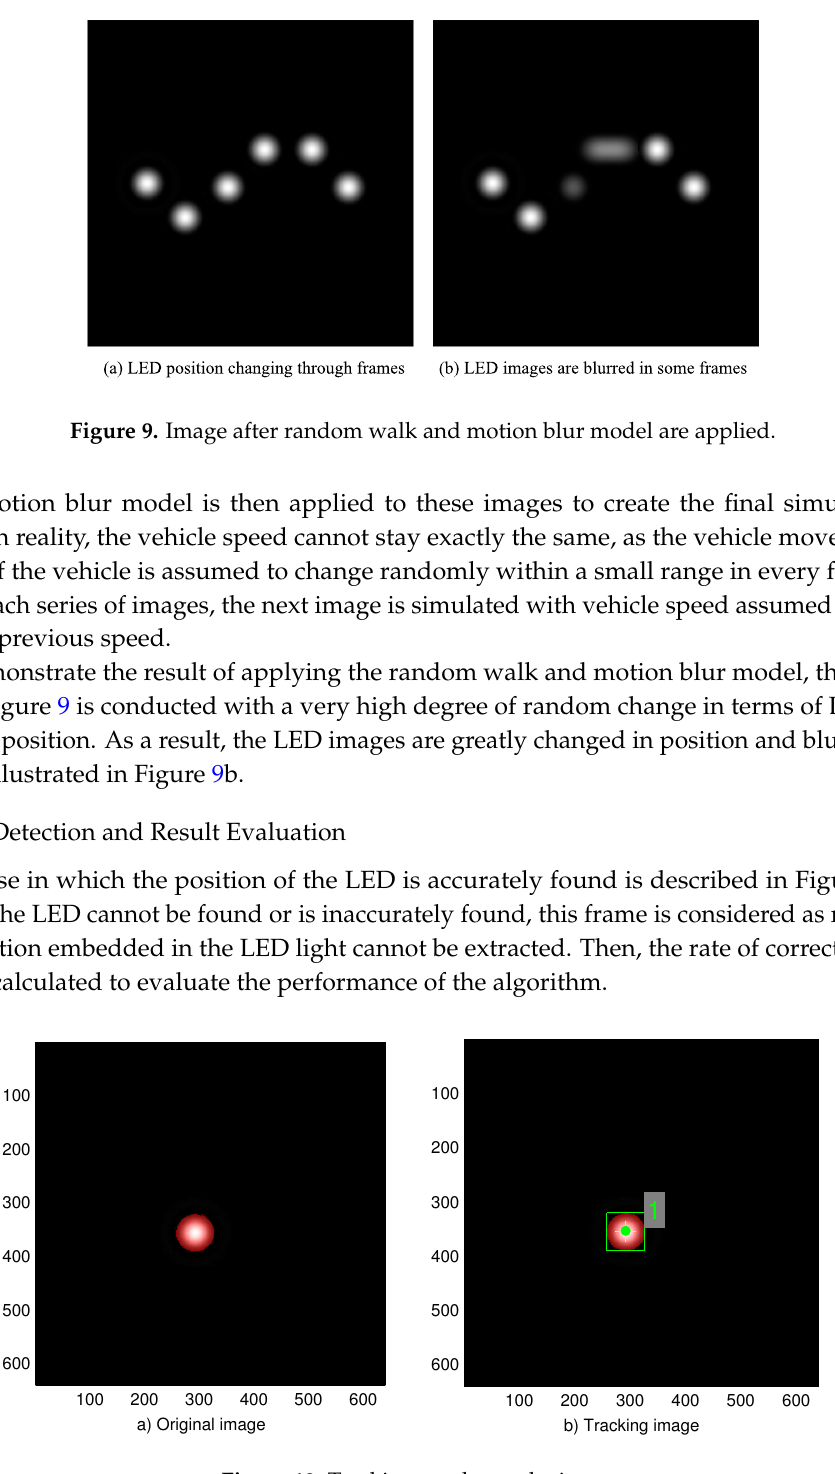
Figure 10. Tracking results on the